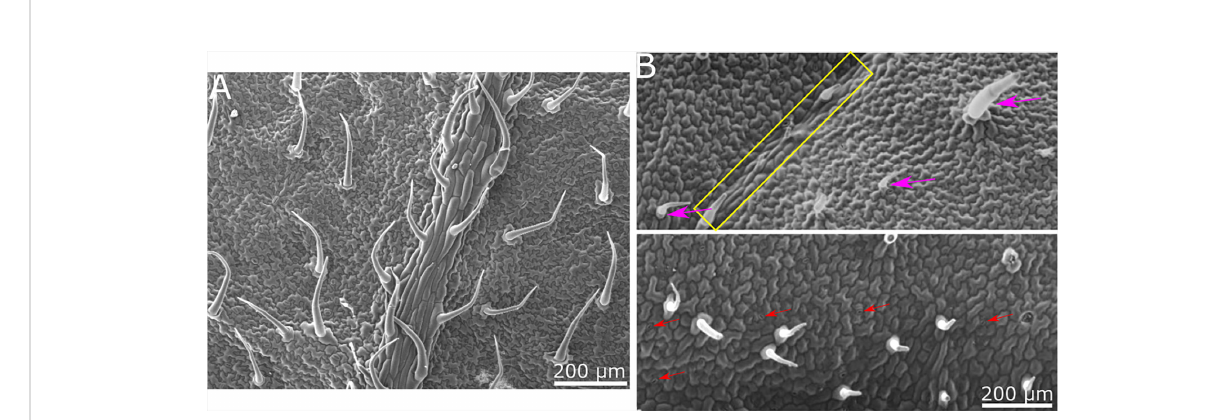
FIGURE 2 SEM images of tomato leaf and replica made of PDMS. (A) SEM micrograph of tomato leaf. (B) SEM micrograph of PDMS replica. All relevant structural features of the tomato leaf surface are visible in the replica. Secondary vein is indicated by a yellow rectangle in the upper image. Trichomes are marked with purple arrows in the upper image. Stomata are indicated with red arrows in the lower image. Epidermis cell structure is also